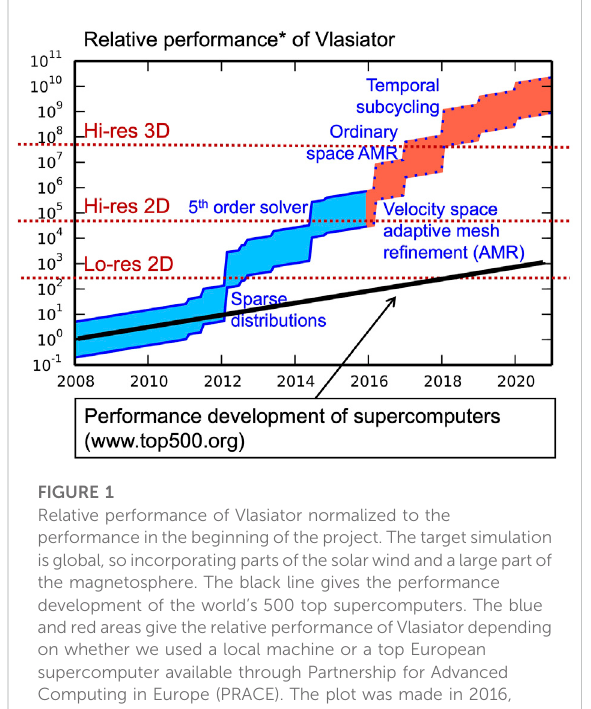
FIGURE 2 Firstglobalviewofthe6DVlasiator,depictingplasmadensity. Solar wind comes to the simulation box from the right, and a real- size dipole sits in the origin. Every ordinary space grid cell includes a velocity space, where the ion VDF can have an arbitrary form. The solution allows to investigate ion-kinetic phenomena within the global magnetosphere, including also physics that is beyondtheMHDdescription,likeHall fi eldsinreconnection,drifts, instabilities, co-located multi-temperature plasmas, fi eld-aligned and fi eld-perpendicular velocities, just to name a